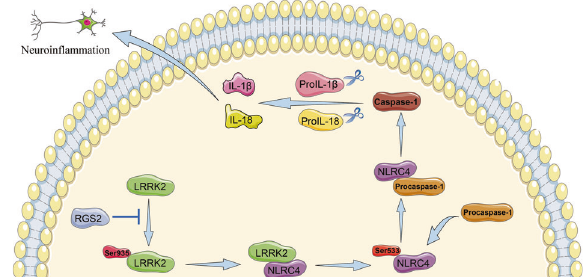
Fig. 9 The role of the NLRC4 in fl ammasome in neuroin fl ammation after ICH. A pattern diagram showed that the NLRC4 in fl ammasome plays a role in ICH-induced neuroin fl ammation and that RGS2 regulates NLRC4 in fl ammasome activation by LRRK2 after